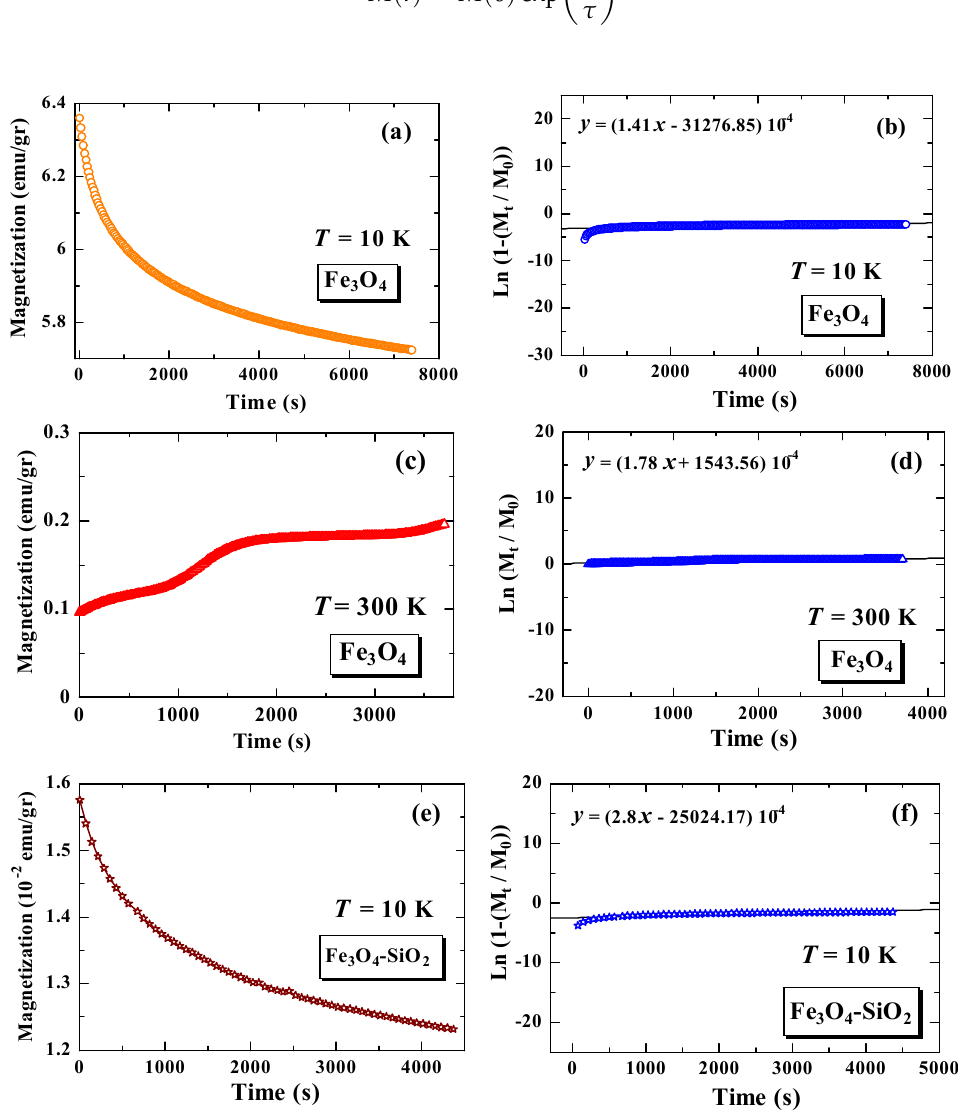
Figure 6. Time dependence of magnetization for Fe 3 O 4 at T = 10 K ( a ), fitting curve of Fe 3 O 4 at T = 10 K ( b ), Fe 3 O 4 at T = 300 K ( c ), fitting curve of Fe 3 O 4 at T = 300 K ( d ), Fe 3 O 4 -SiO 2 at T = 10 K ( e ), and fitting curve of Fe 3 O 4 -SiO 2 at T = 10 K ( f ).